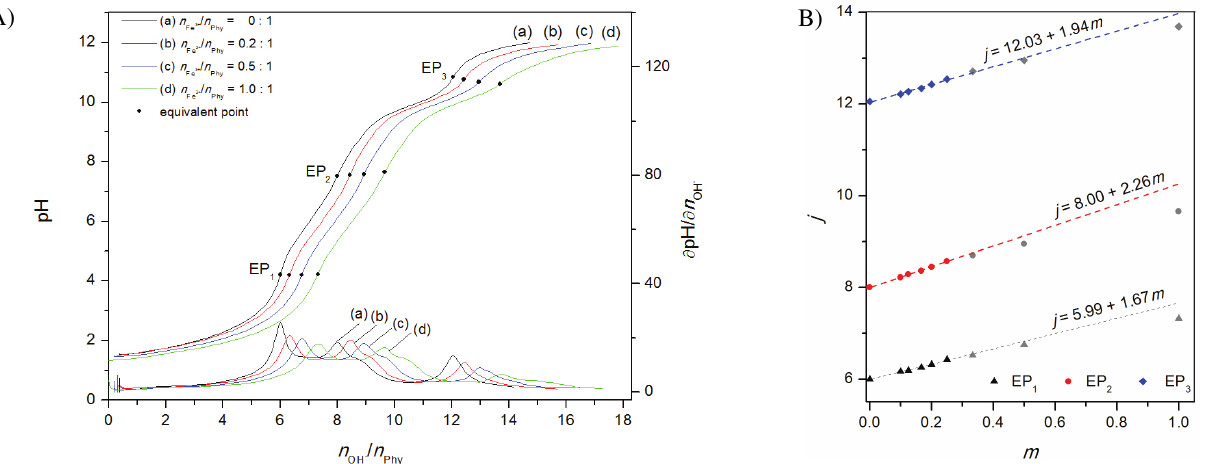
Figure 7. (A) Titration of 0.3104 mmol H Phy (in the presence of 0.25 M NaCl) with 0.1008 M NaOH at various molar ratios n 12 0.2:1, (c) 0.5:1, and (d) 1:1, accompanied with corresponding derivatives ∂ pH/ ∂ n lar ratios m ( m = n / n ) consumed at different EPs from part Fe Phy